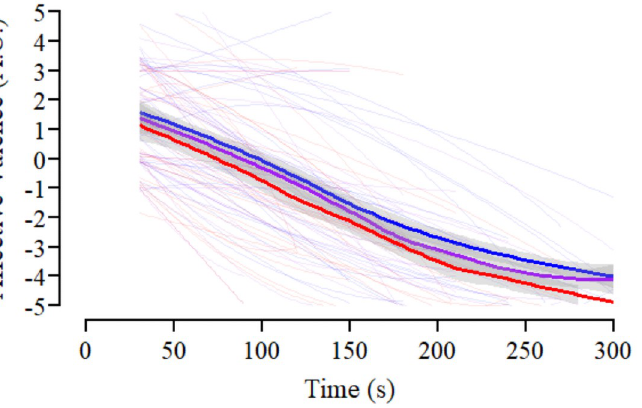
Fig 5. Effect of experimental conditions on affective valence during the endurance task. Profile of reported affective valence across the knee extensor (KE) endurance task within the control (CON; blue), moderate RoF (MOD; purple) and severe RoF conditions (SEV; red). Individual responses across time are displayed by smoothed thin lines within each condition. Thick lines represent the change in mean scores over time in each condition, with grey boarders representing 95% confidence